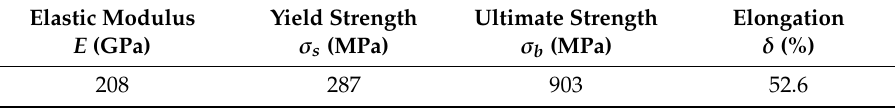
Figure 4. Flow stress curve of AISI 304 stainless steel. Table 1. Mechanical properties of AISI 304 stainless steel.